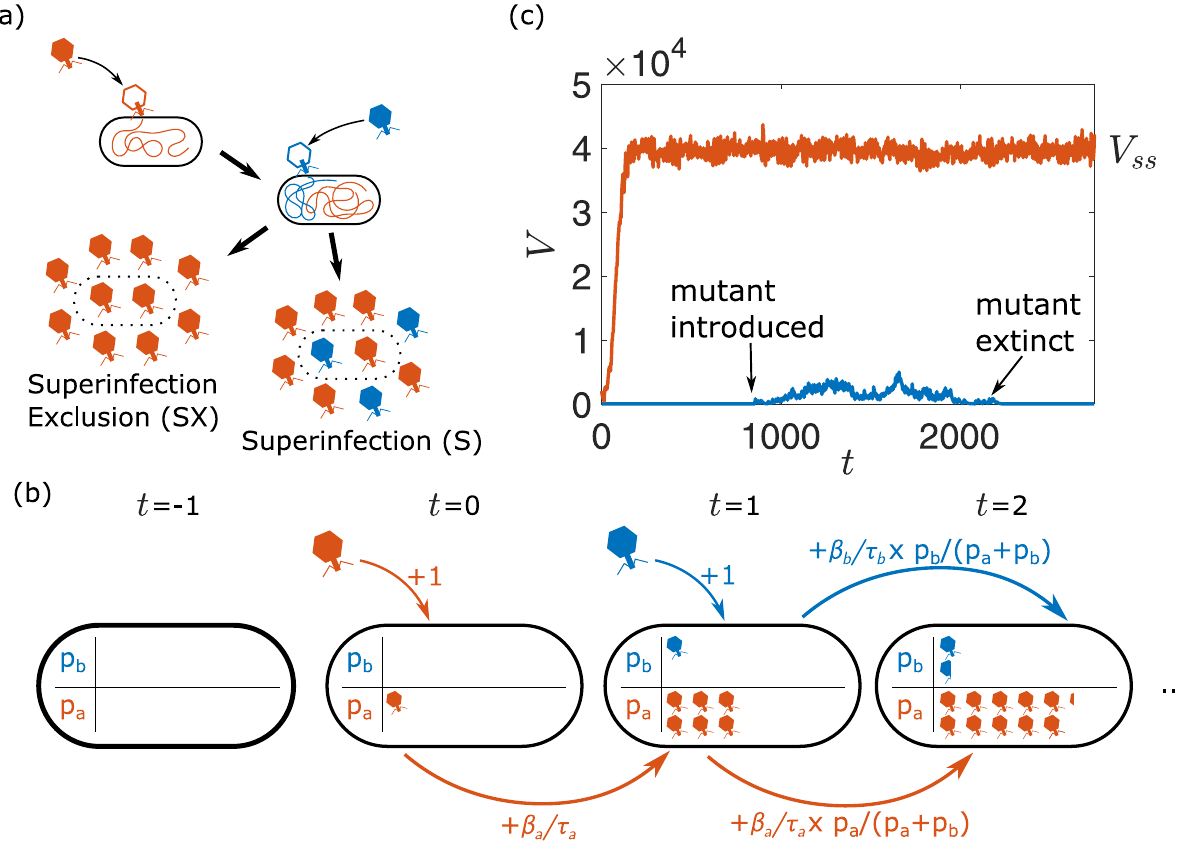
Fig 1. Modelling setup. (a): In superinfection-excluding scenarios, all of the progeny released as the cell lyses are copies of the initial infecting phage, whereas when superinfecting is permitted, the progeny are split between both types of phage. (b): During superinfection, pseudo-populations p a and p b are used to represent the growth of phage inside the host cells. These populations increase by 1 whenever a phage infects the host, and each population increases by some fraction of its rate β / τ determined by the relative size of the populations in the previous step. (c): An example realisation of the simulation. The resident phage population initially grows until it reaches a steady state, at which point a mutant phage is introduced to the population, and the simulation is run until extinction or fixation of the